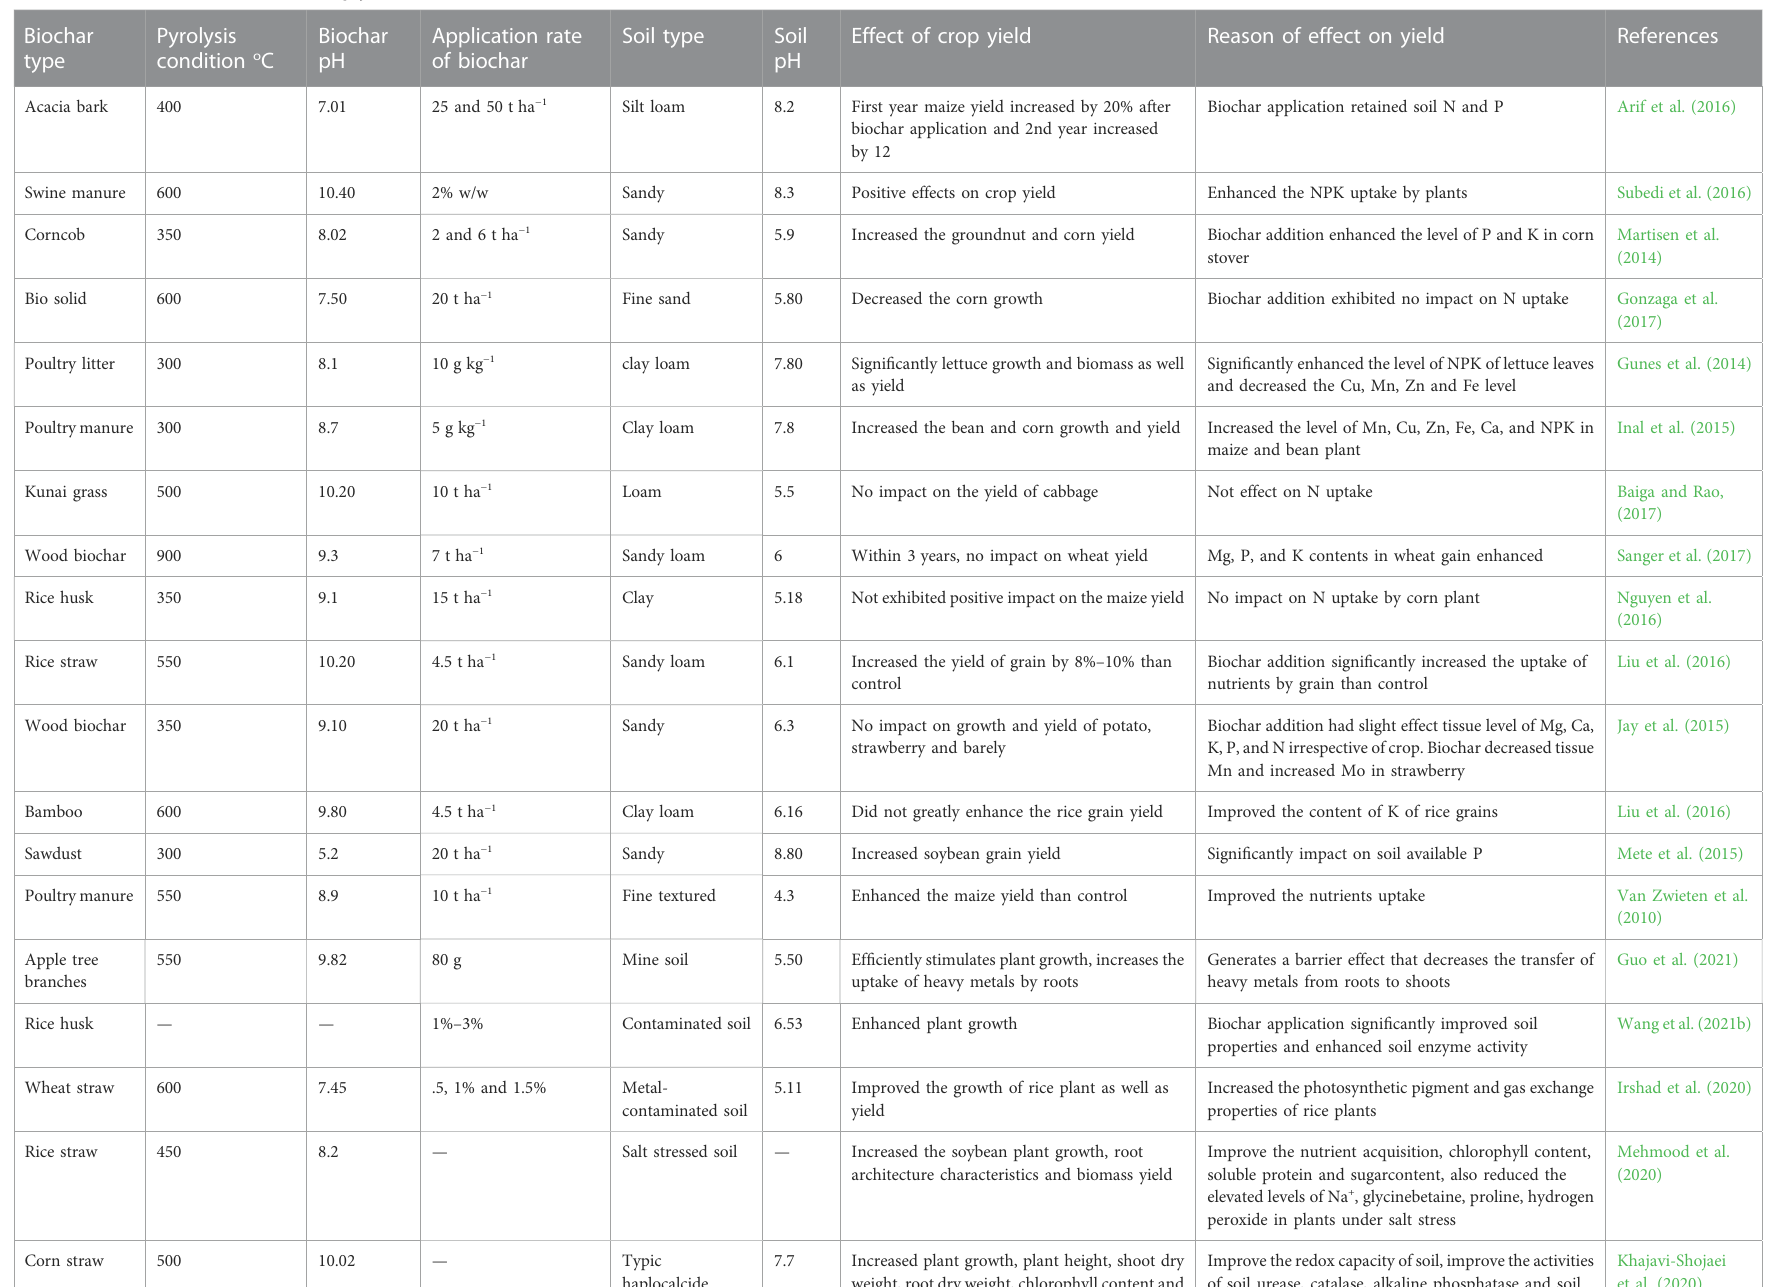
TABLE 7 Effect of biochar addition on crop